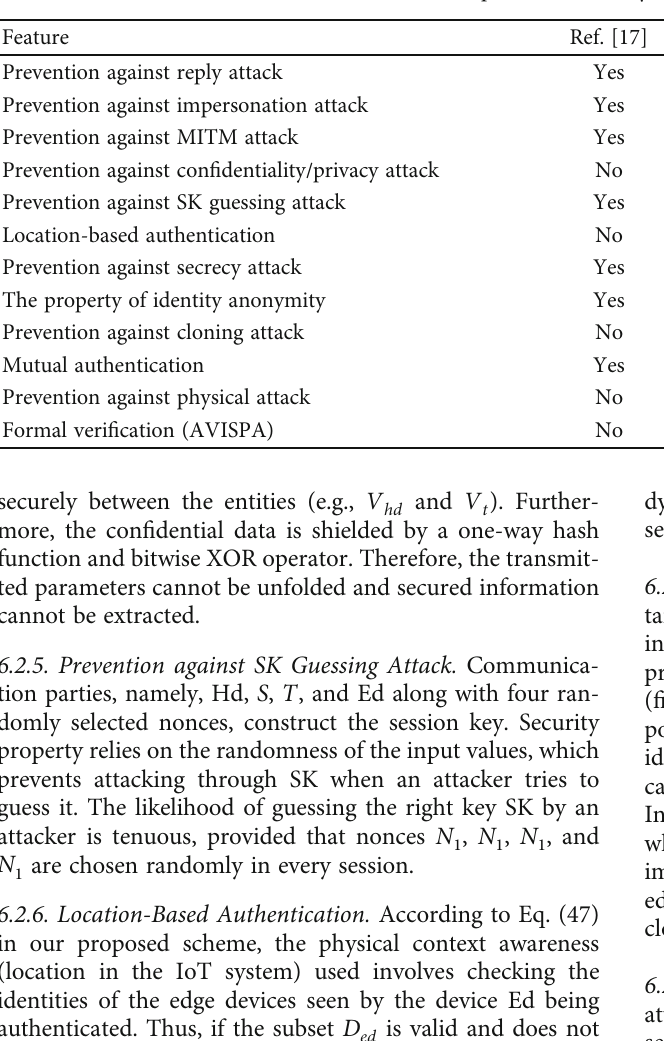
Table 4: A comparison of security-based functionality